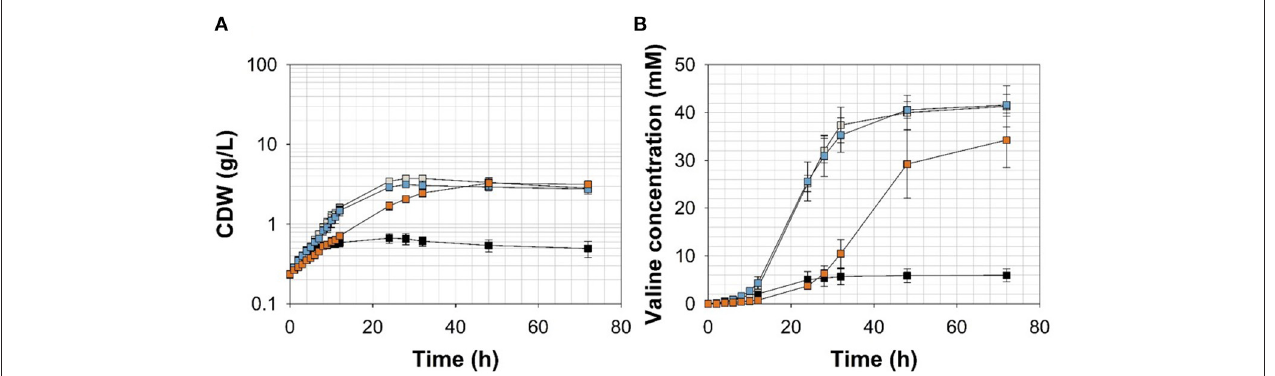
FIGURE 5 | (A) Growth and (B) valine accumulation in the supernatant of C. glutamicum 1 P aceE :: vanR -P vanABK *(pJC4- ilvBNCE ) in shaking flasks with CGXII minimal medium (with 20g ammonium sulfate L − 1 ) and 20g glucose L − 1 without (black) and with ferulic acid (gray), vanillin (blue), or vanillic acid (orange) (for detailed concentration of effector molecules see Supplementary Figure 5 ; Table 3 ). Error bars represent standard deviation of cultivations of at least three biological